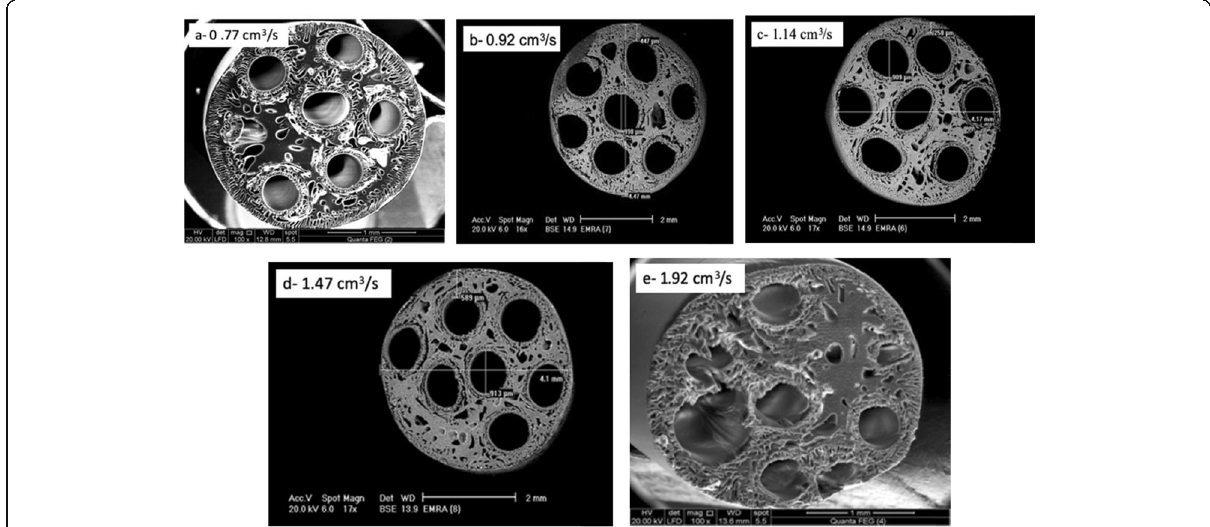
Fig. 11 Effect of dope solution on the 7 MBHF membrane